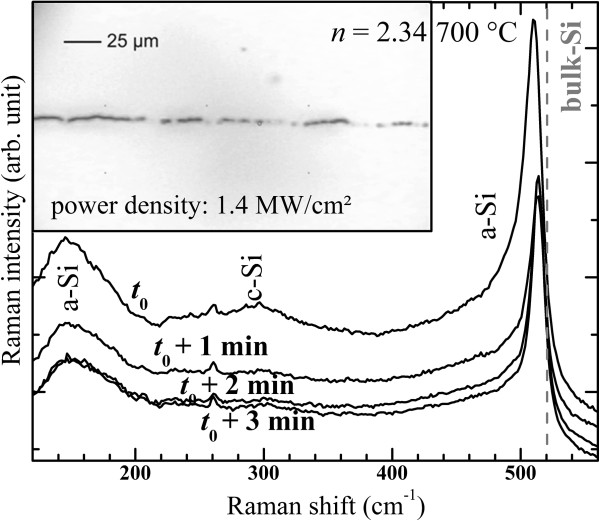
Effect of the irradiation duration on the Raman spectra of SiNxfilms during the laser annealing. The inset shows the picture of the laser spot course on the SiNx layer.